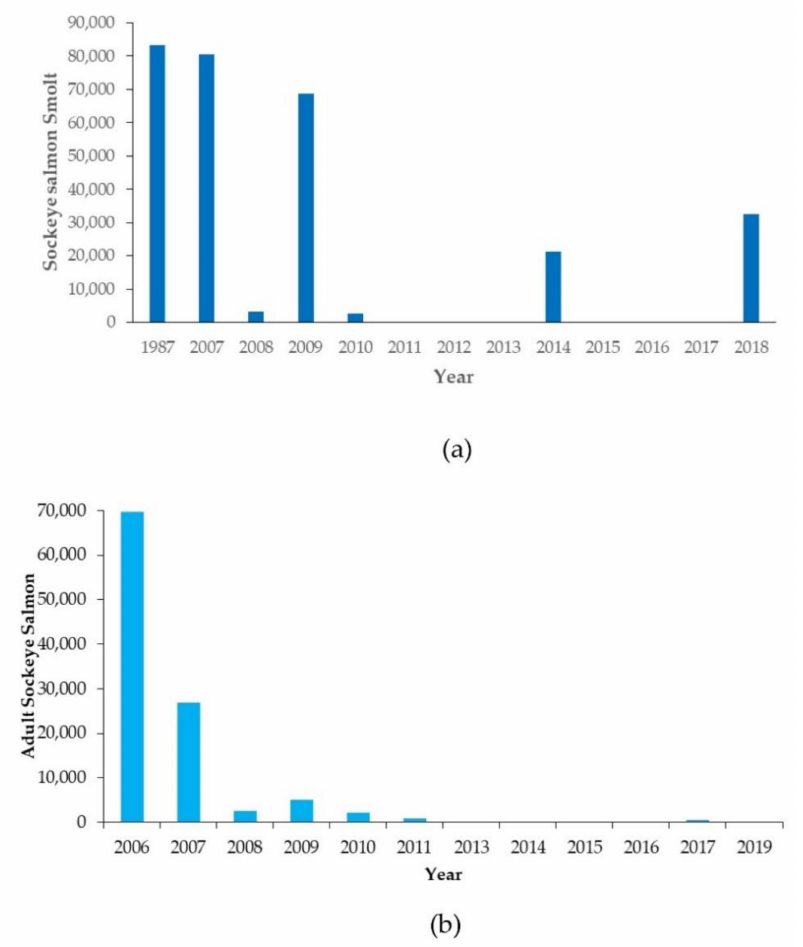
Figure 6. ( a ) Sockeye smolt counts in Shell Lake in 1987 and from 2007–2018 ( b ) Weir counts for adult sockeye in Shell Lake from 2006–2011, 2013–2017, and 2019. CIAA collected eggs from adult sockeye salmon in Shell Lake during 2012, 2016, and